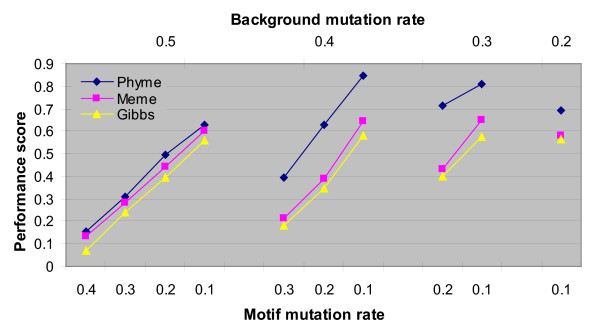
Effect of varying background and motif mutation rates (μb and μm respectively) on motif-finding performance. Each point is an average over 10 experiments with synthetic data. (K = 3, R = 12.)